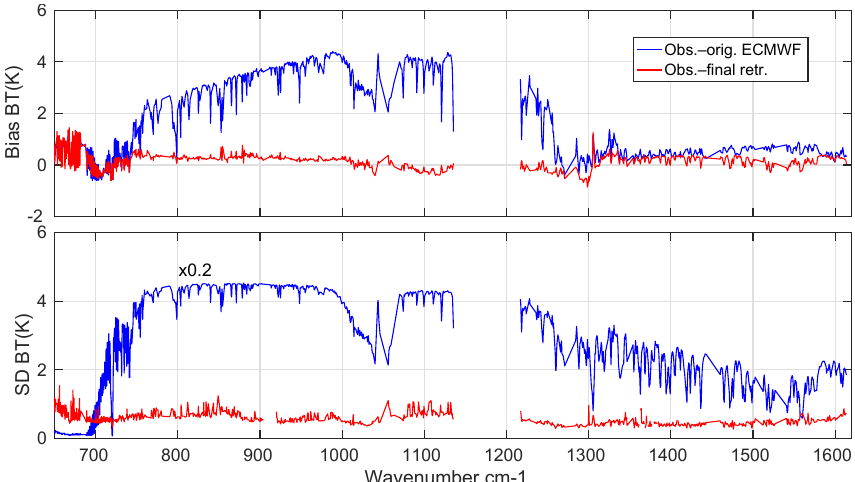
Figure 11. Retrieval results for Granule 039 shown in Fig. 9. The original biases between observations and ECMWF before the retrieval and cloud replacement are also shown (in blue); note that this standard deviation has been reduced by 5 × for plotting.